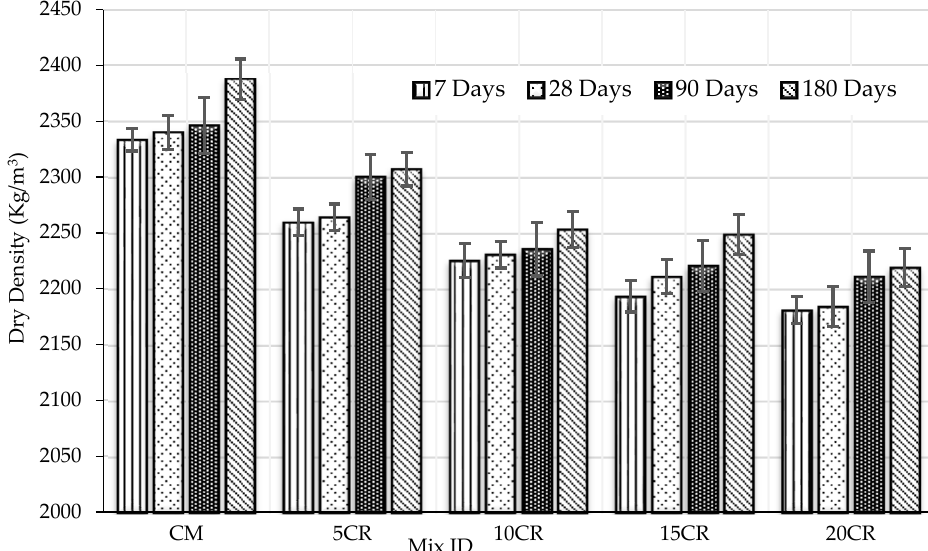
Figure 8. Results of dry density for different